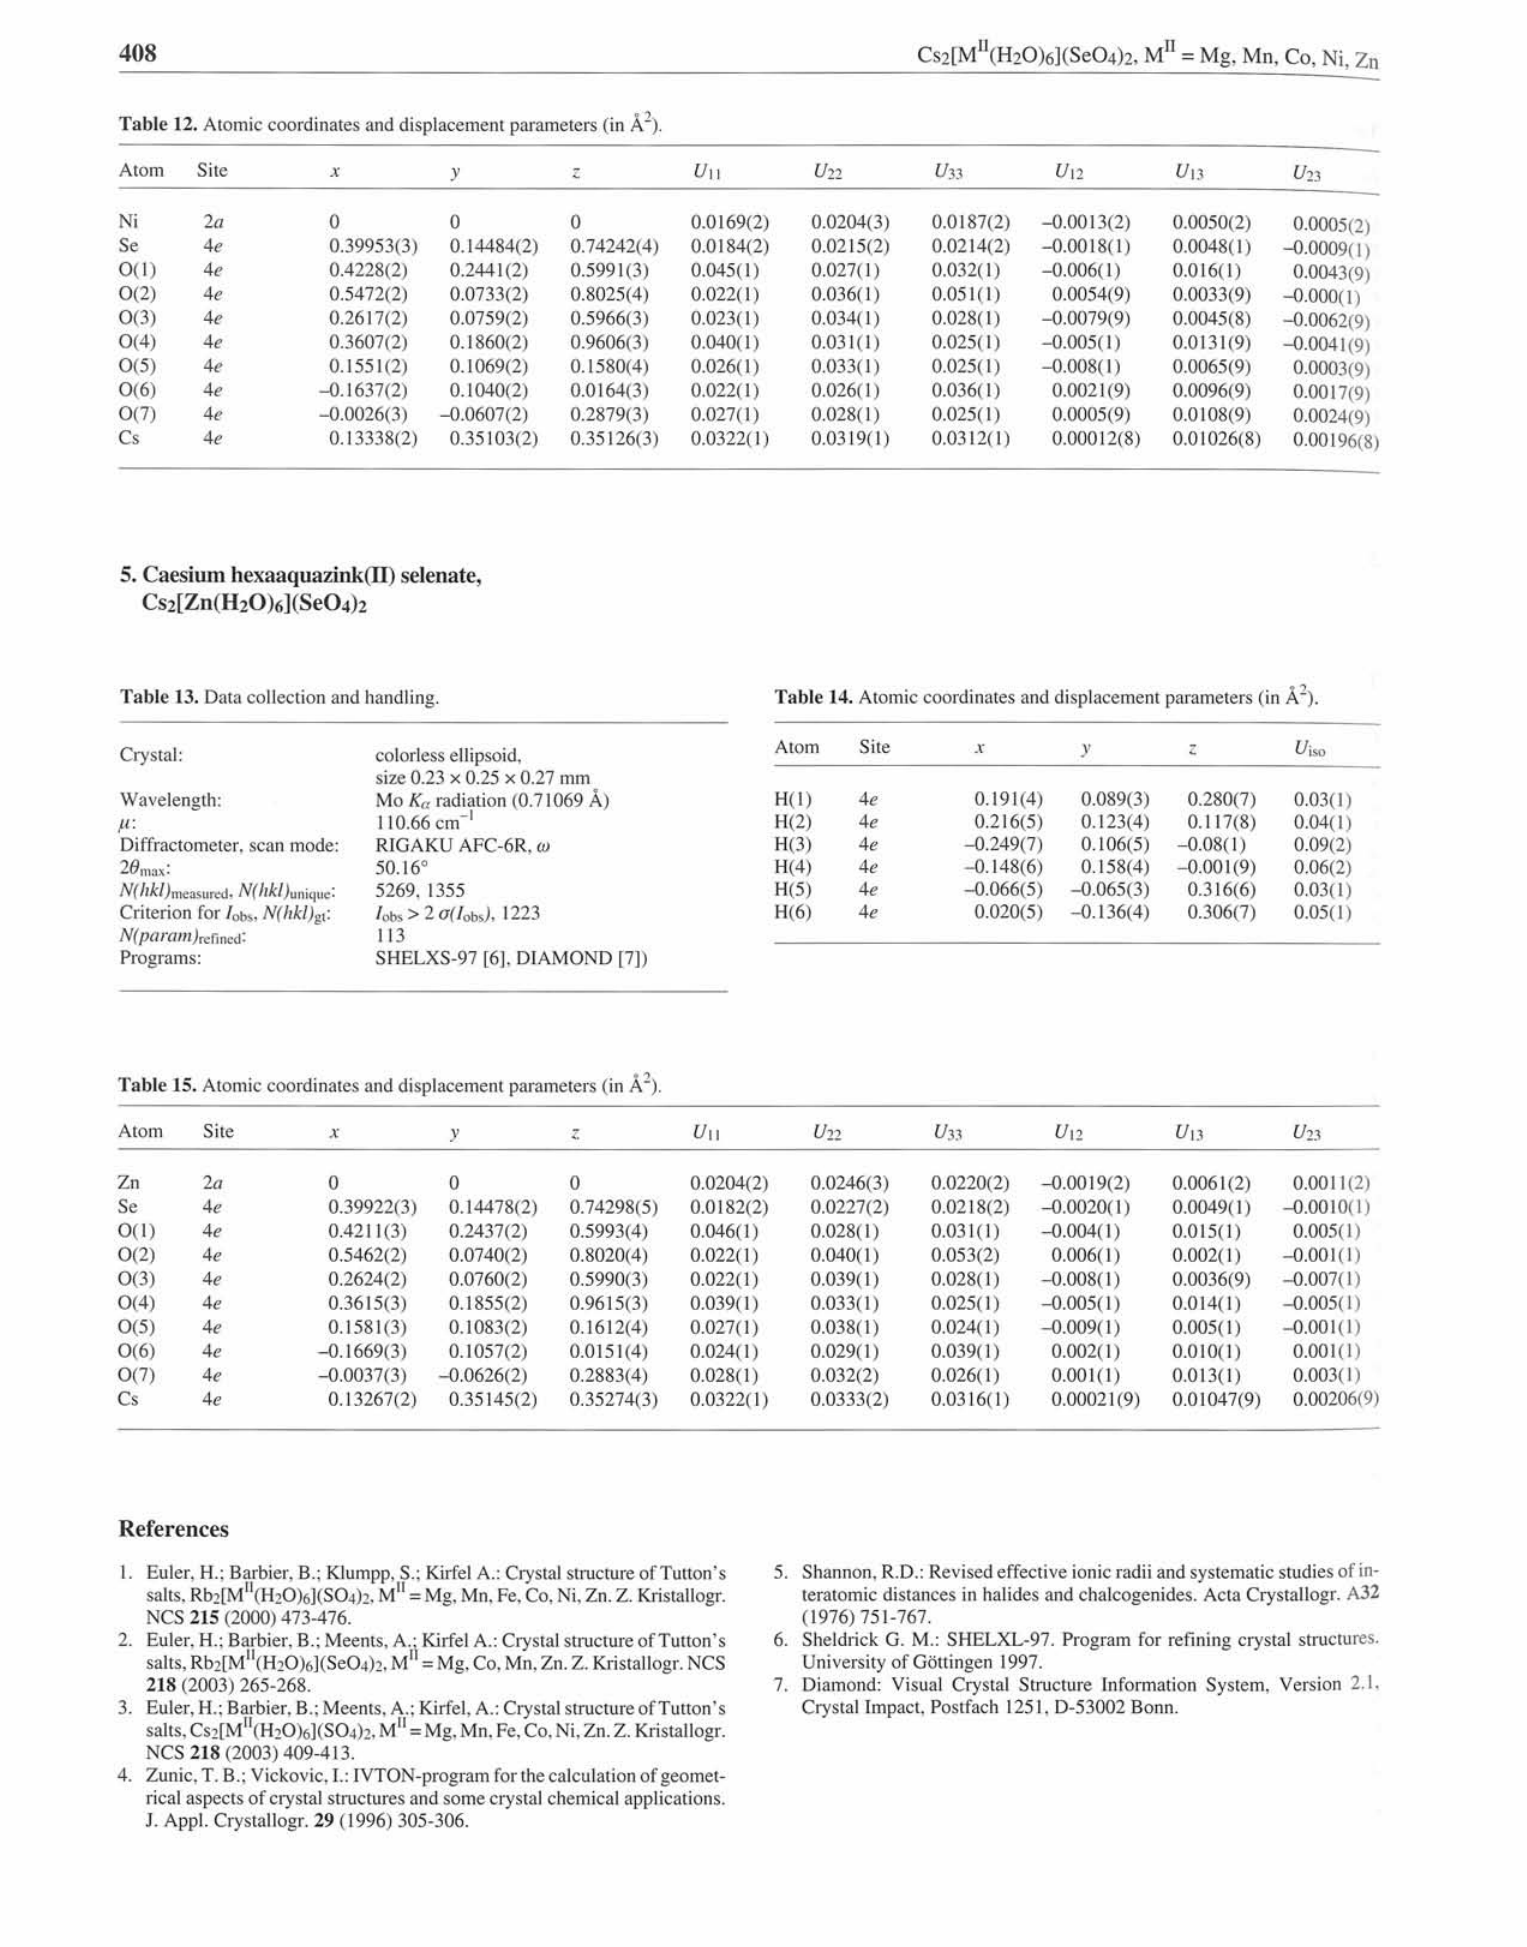
Table 12. Atomic coordinates and displacement parameters (in Â 2 ).